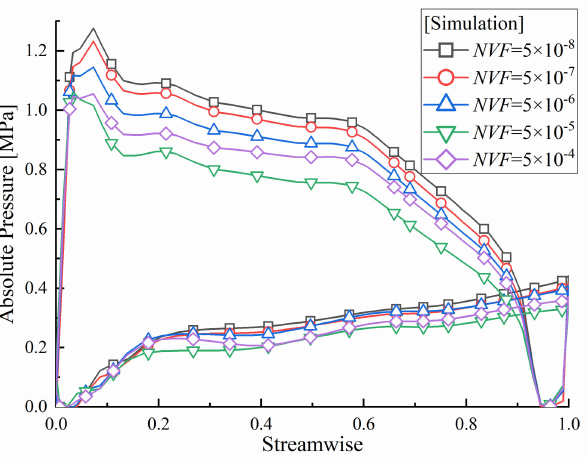
Figure 12. Absolute pressure on stator blade at stall under various nuclei volume fractions.